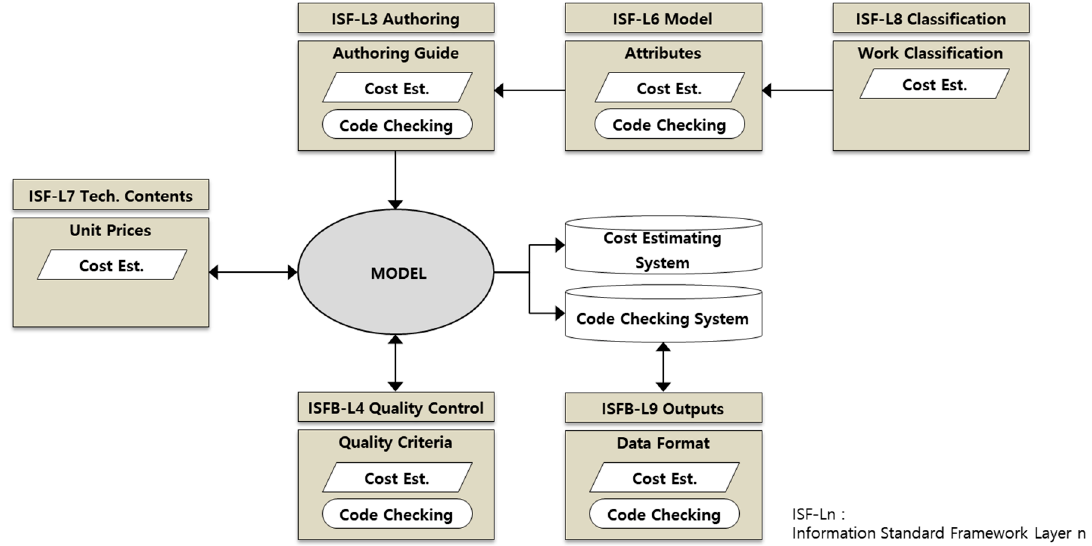
Figure 7. Test concept diagram of the common master standard module.